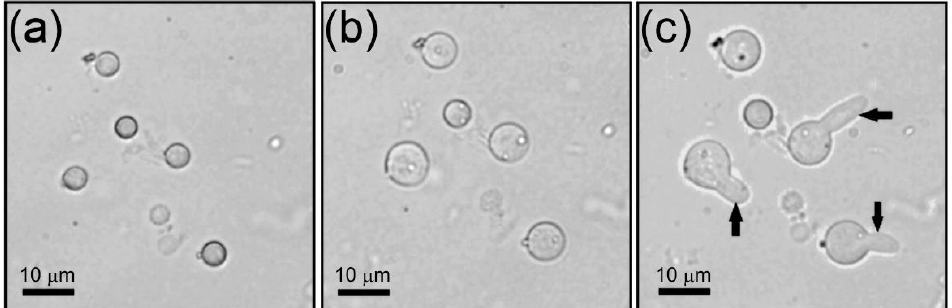
Figure 3. Optical microscope images showing A. niger conidia ( a ) at 0 h, i.e., just after being inoculated in the culture medium, ( b ) during swelling or isotropic growth after 6 h, and ( c ) after germ tube formation or polarized growth (see arrows) at 8 h.